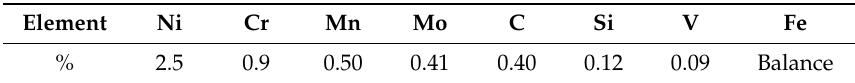
Table 1. Chemical composition of AISI 4340.